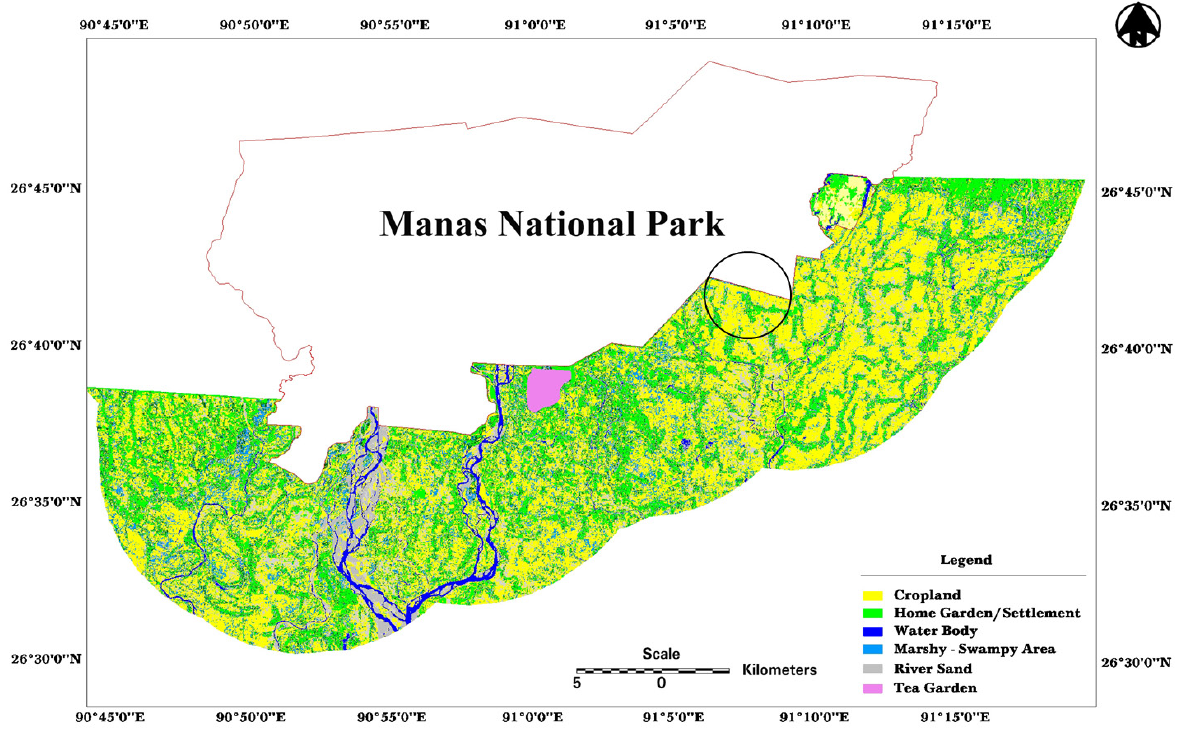
Figure 2. Location of the sampled area (within the